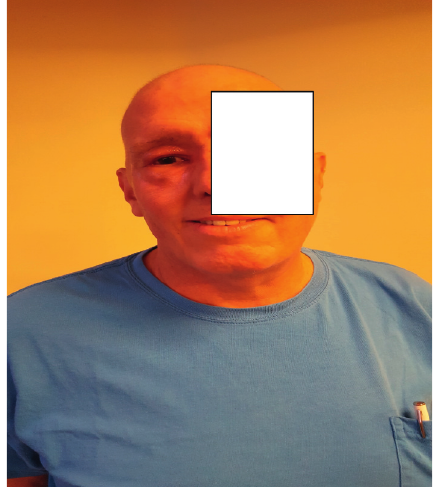
Figure 5: Significant resolution of the right periorbital edema and erythema was noted after 3 cycles of chemotherapy. The right eye was eventually able to fully